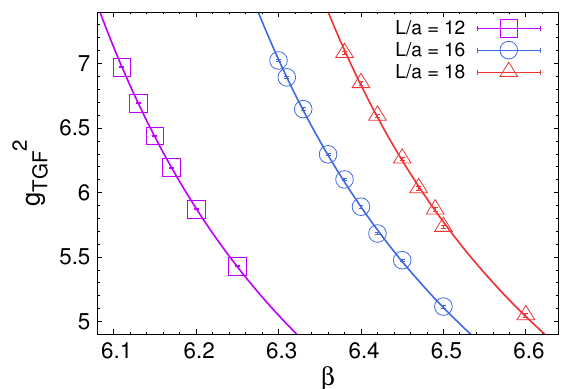
Figure 3 . g 2 (1 =L; (cid:12) ) vs (cid:12) at each lattice size. The solid lines show the (cid:12)t results with eq. (5.2). TGF